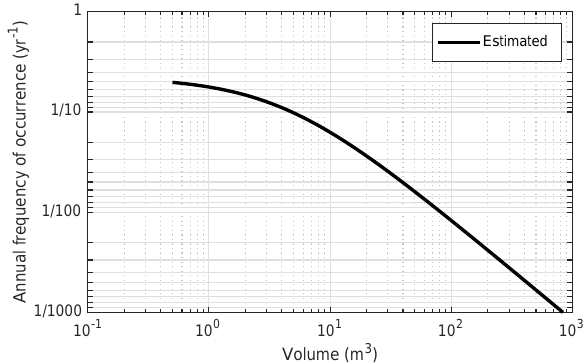
Figure 4. Volume–annual frequency of occurrence plot related to Buisson